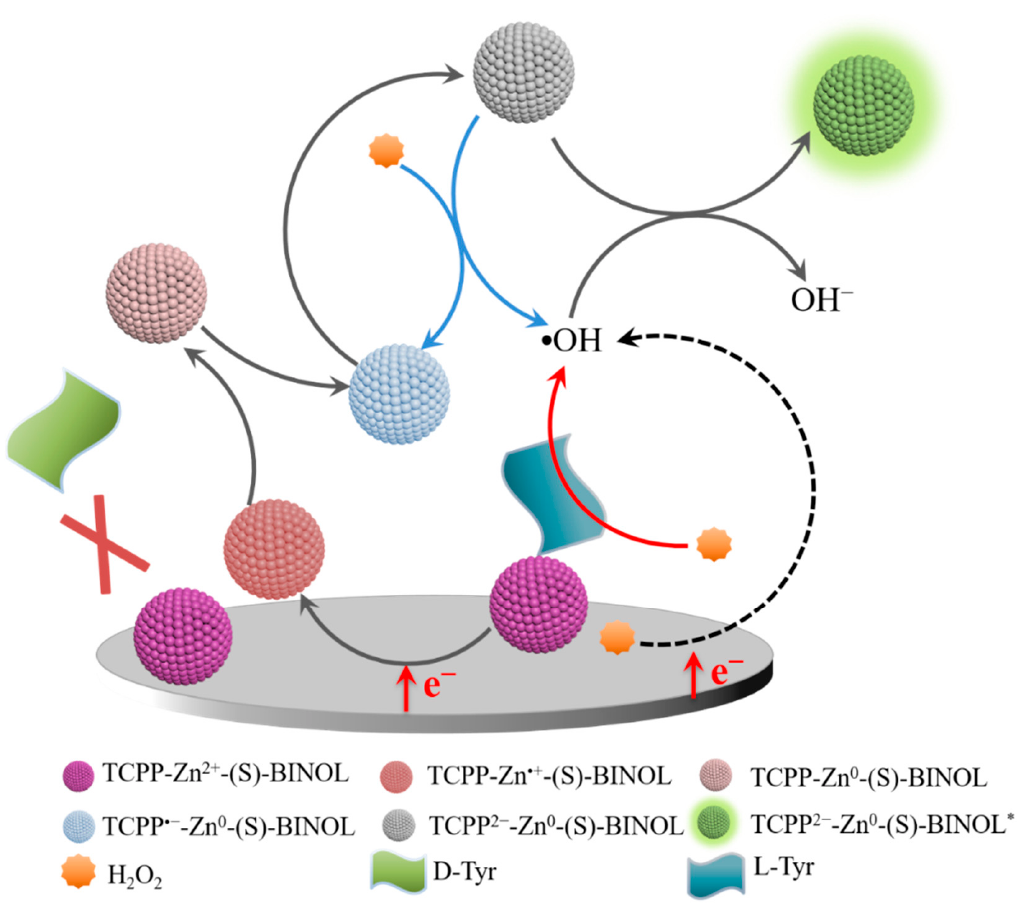
Scheme 4. Schematic illustration showing the mechanisms of ECL chiral recognition.